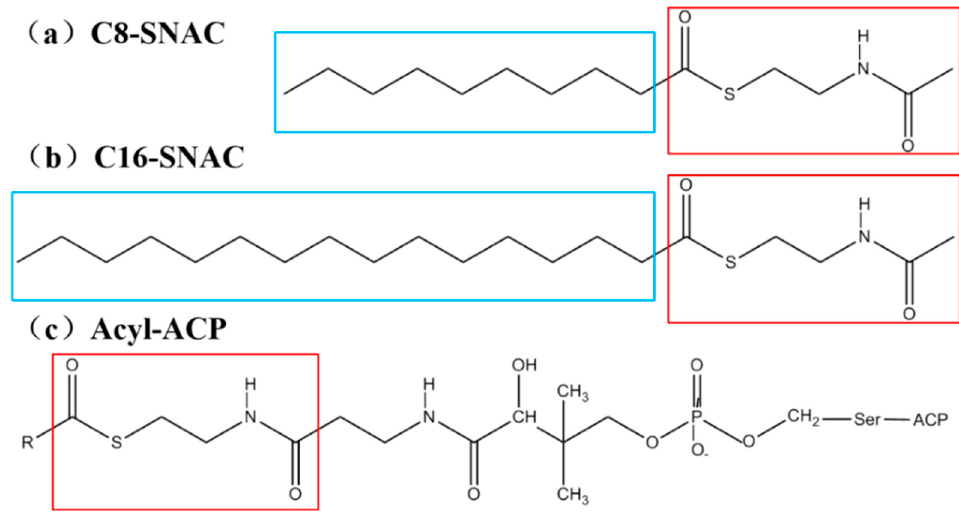
Figure 2. The structures of the substrates commonly used in experiments and MD simulations. Compound ( a ) and compound ( b ) are the substrates octanoyl- N -acetylcysteamine analog (C8-SNAC) and hexadecanoyl acyl- N -acetylcysteamine analog (C16-SNAC) in MD simulations, respectively, and compound ( c ) is the substrate acyl-acyl carrier protein (Acyl-ACP) in experiments. The red rectangles are the same parts of the structures of the three compounds, representing the polar amide end. The blue rectangles represent the non-polar aliphatic chain ends containing 8 and 16 carbons, respectively.